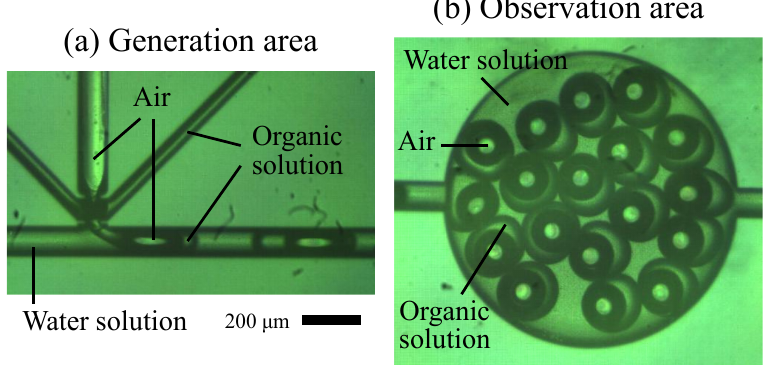
Figure 3. Images of G/O/W microdroplets in ( a ) the generation area within the multiphase junction and ( b ) the observation area.